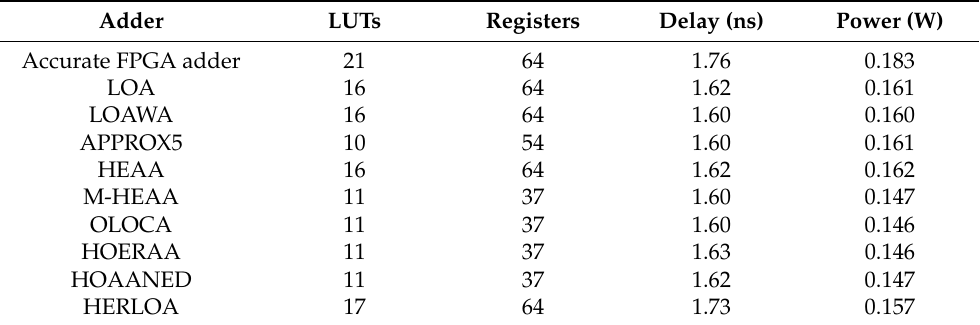
Table 4. FPGA-based design parameters of accurate and approximate 21-bit adders; the approximate adders have an 11-bit inexact